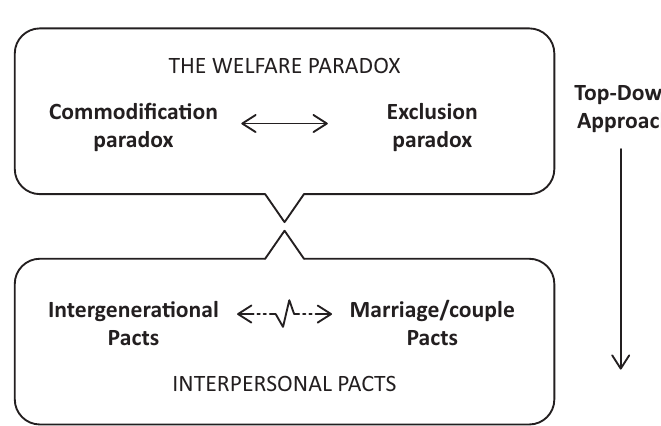
Figure 1. The “welfare paradox” and the “interpersonal pacts” in transnational social protection. Social Inclusion, 2022, Volume 10, Issue 1, Pages